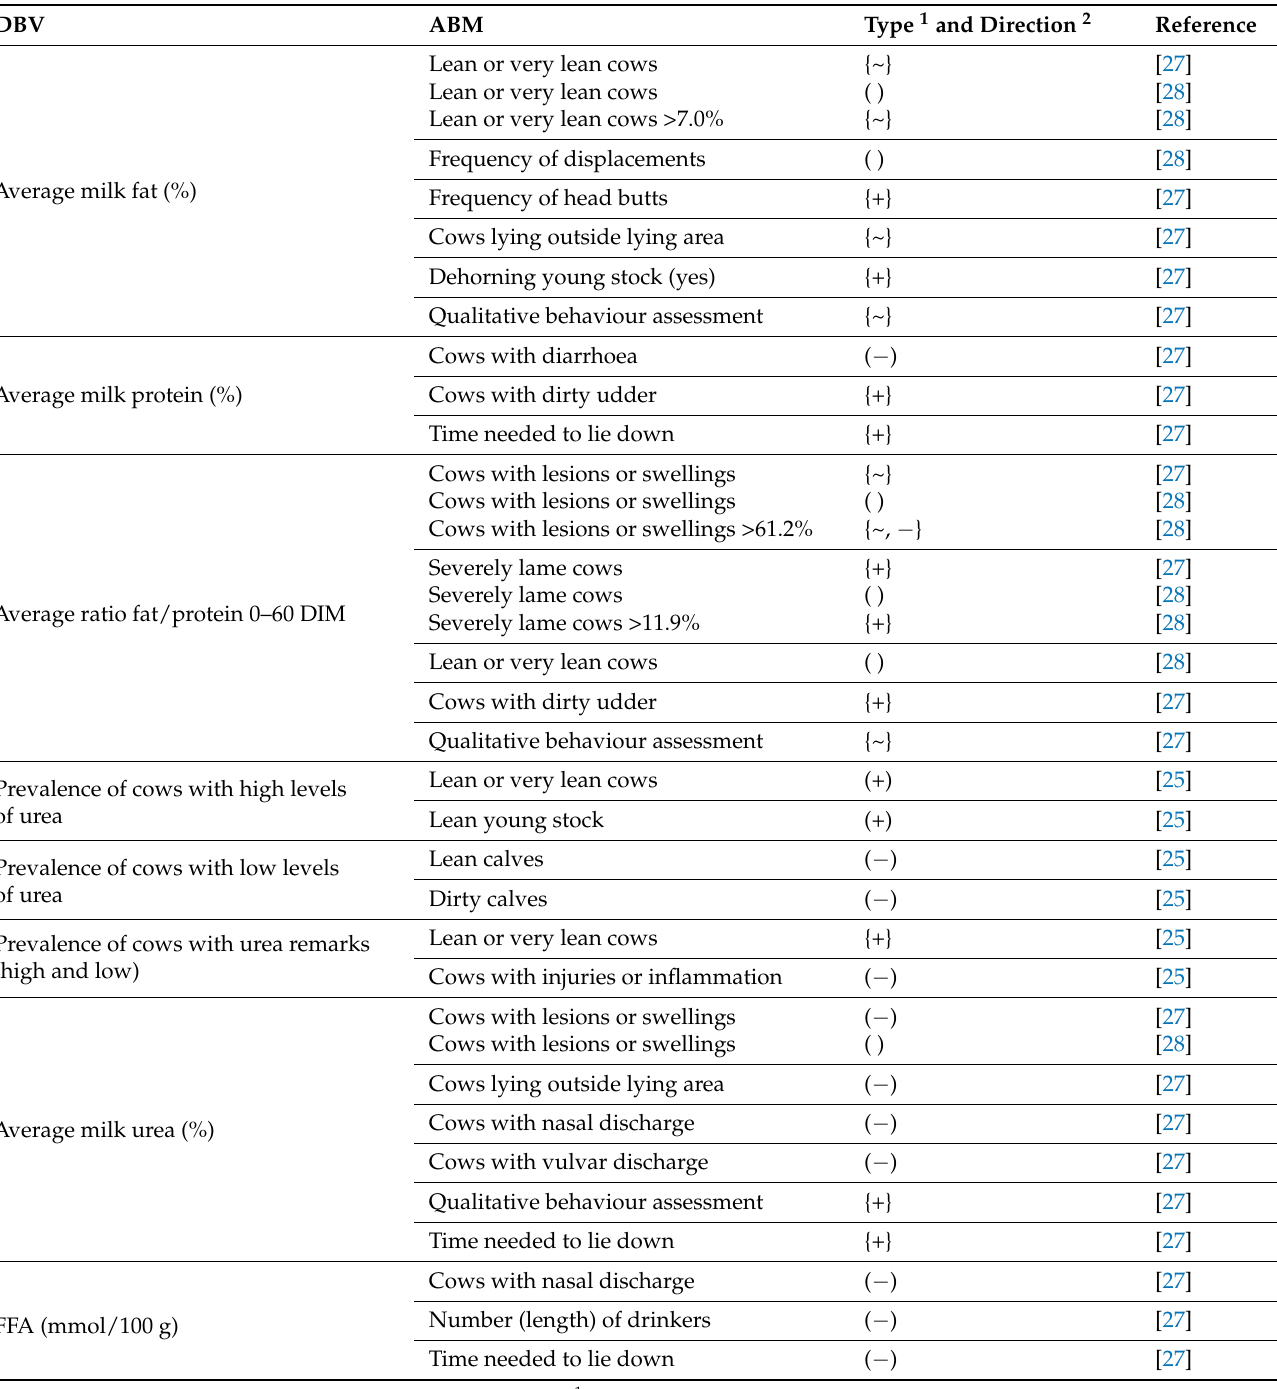
Table 11. Associations between data-based variables (DBVs) based on milk contents and animal-based measurements (ABMs) extracted from three scientific